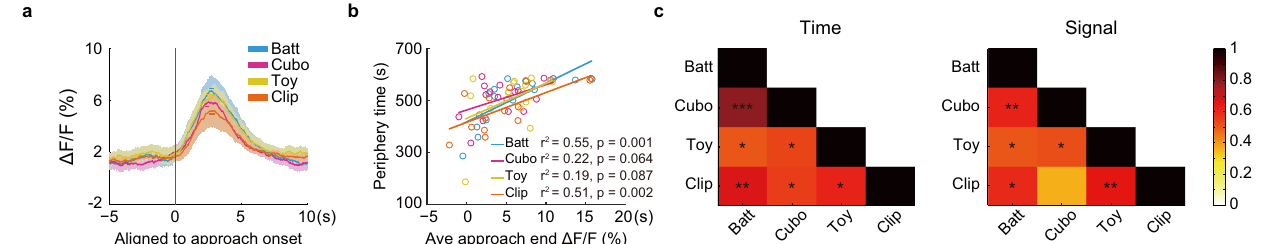
Fig. 2 | Object-evoked AHN Vgat+ activity shows individual speci fi city. a Average Δ F / F signals ± SEM (shades) aligned to approach onset toward different unfamiliar objects: battery (Batt), cuboid cube (Cubo), toy airplane (Toy), and paper clip (Clip). Horizontal lines around the peak values show the average retreat onset ±SEM. b Correlationsbetweenaverageapproach-end Δ F / F valueandthetimespent in the open fi eld periphery zone after the introduction of different objects. n =16